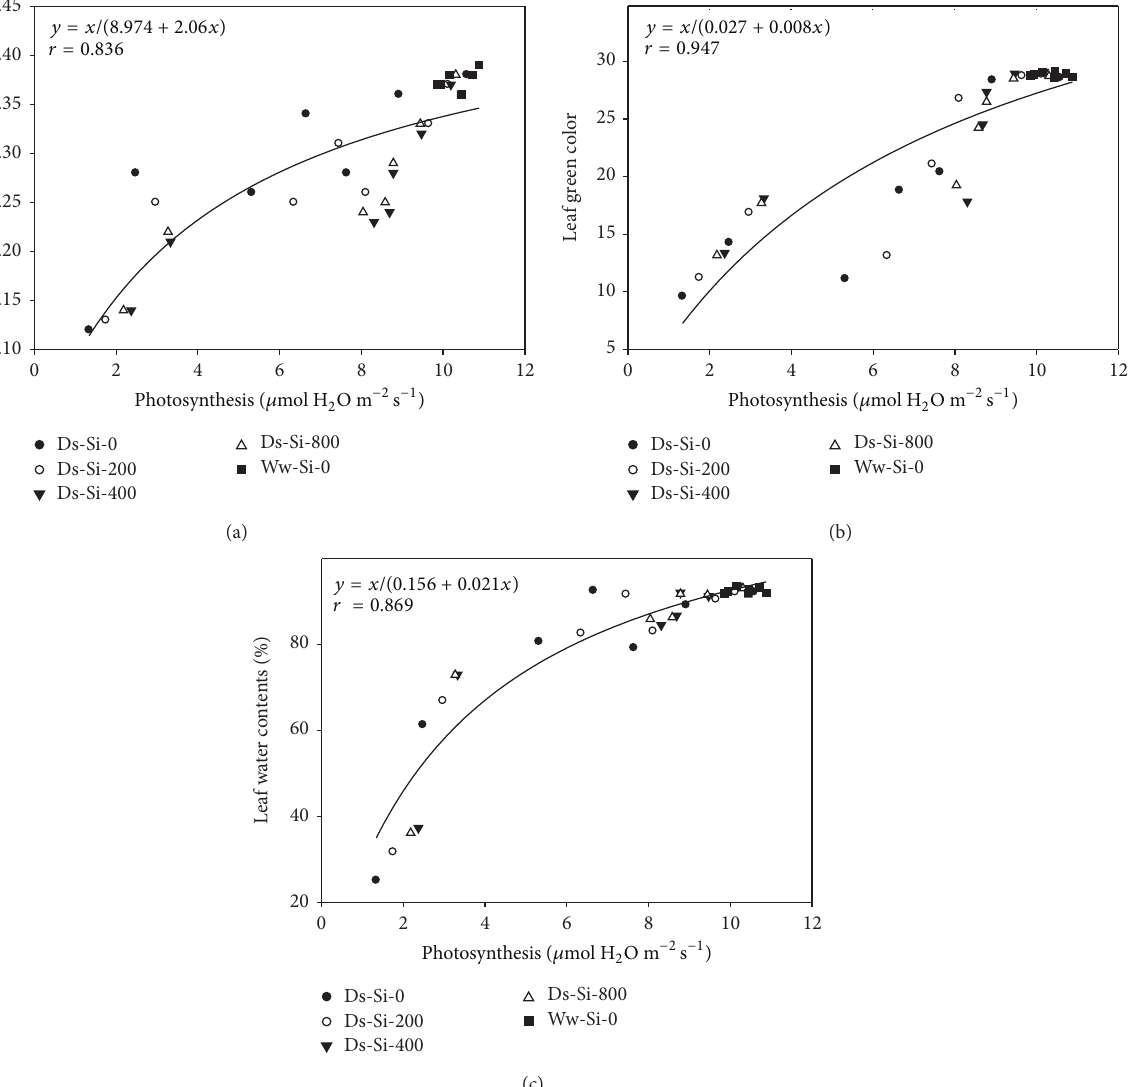
Figure 3: Relationship of net photosynthesis with (a) stomatal conductance, (b) leaf green color, and (c) leaf water contents using hyperbola regression